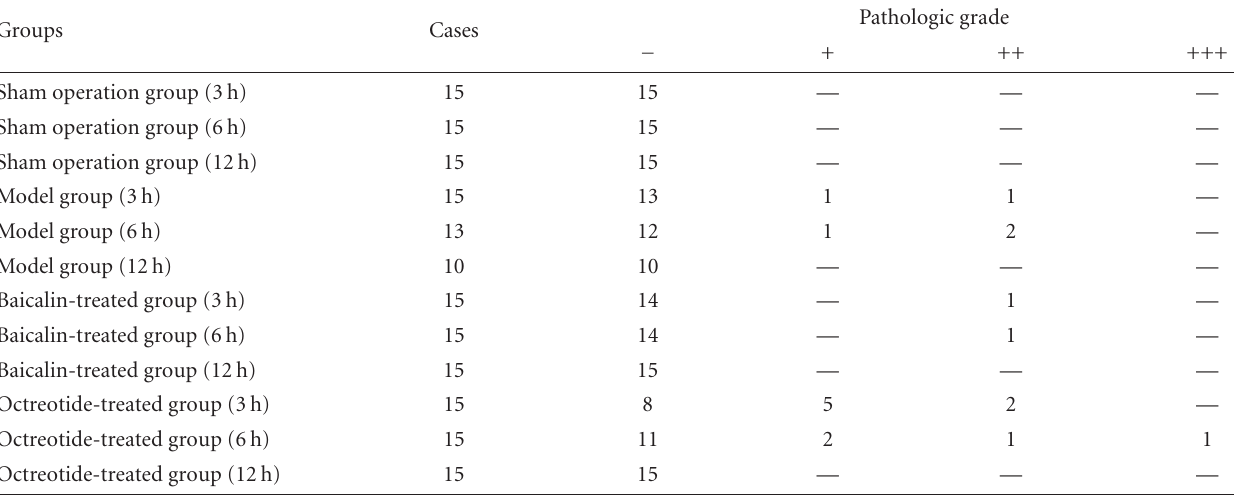
Table 7: Changes of Bcl-2 protein expression in all groups.